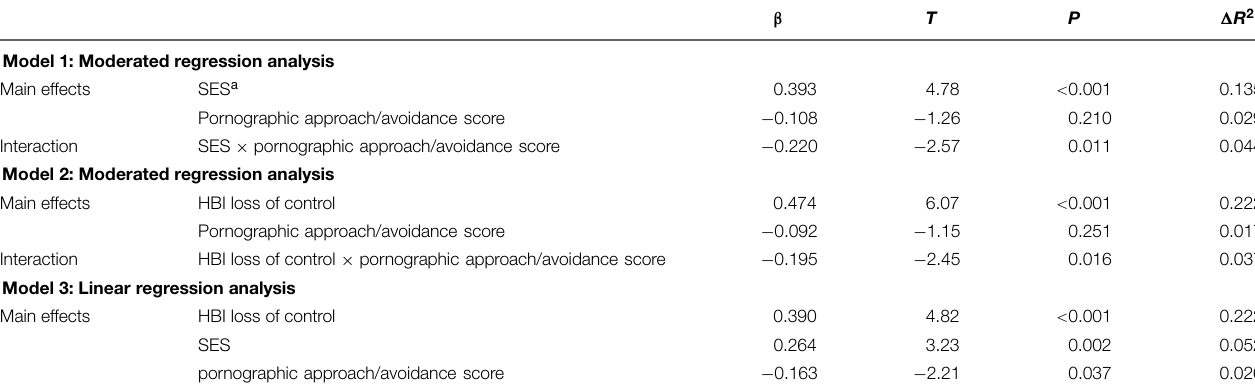
TABLE 5 | Values of the moderated regression analyses with s-IATsex factor craving as dependent variable.